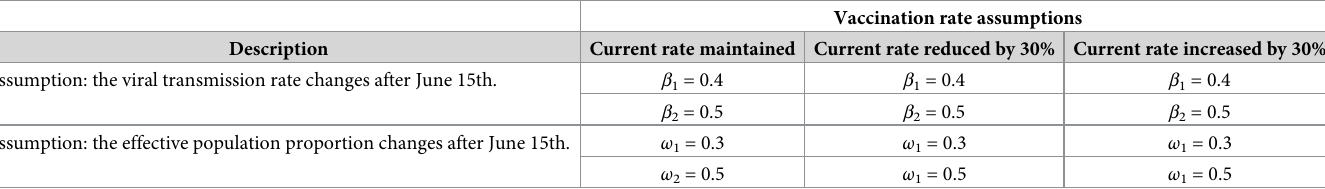
Table 2. Summary of